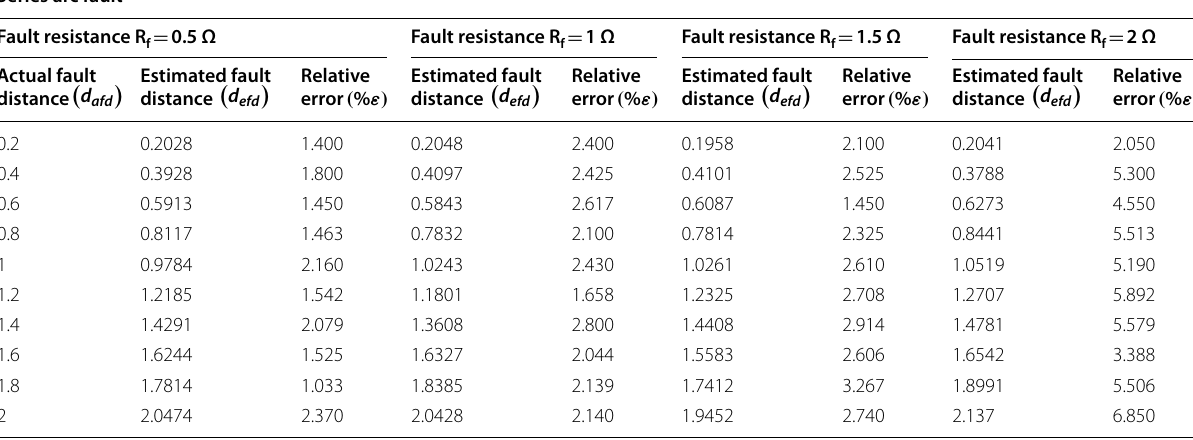
Table 12 Series arc fault distance estimation using FF-RLS algorithm Series arc fault Fault resistance R f 0.5 Ω =